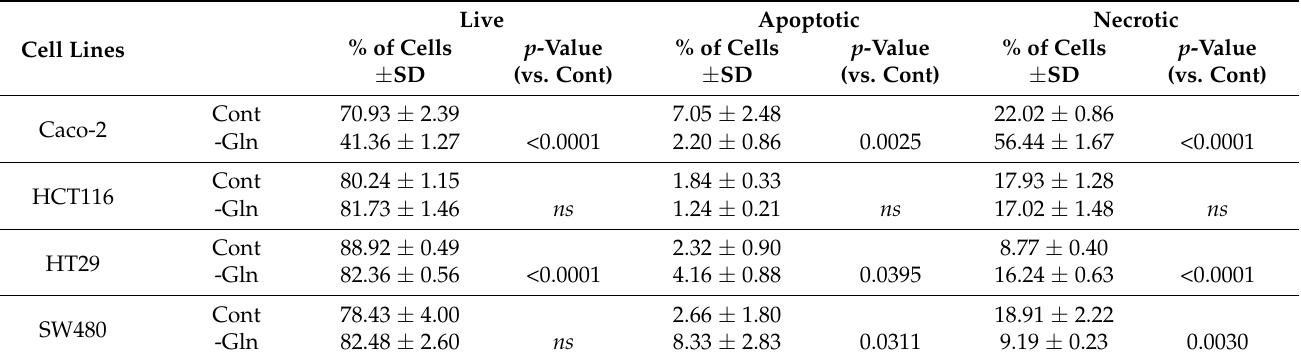
percentages; the experiment was performed in triplicate and represents mean ± SD; ns : not